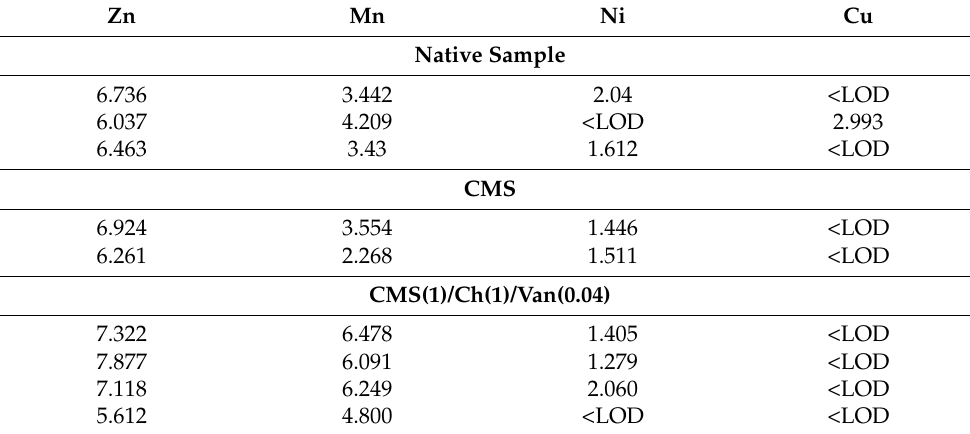
Table 13. The analysis of the Straw elemental